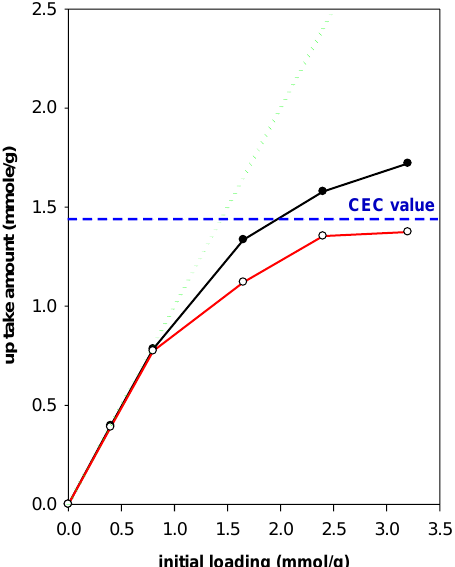
Figure 2. The uptake amount of C16TMA cations by the PG clay as a function of initial loading concentrations using C16TMABr solution.